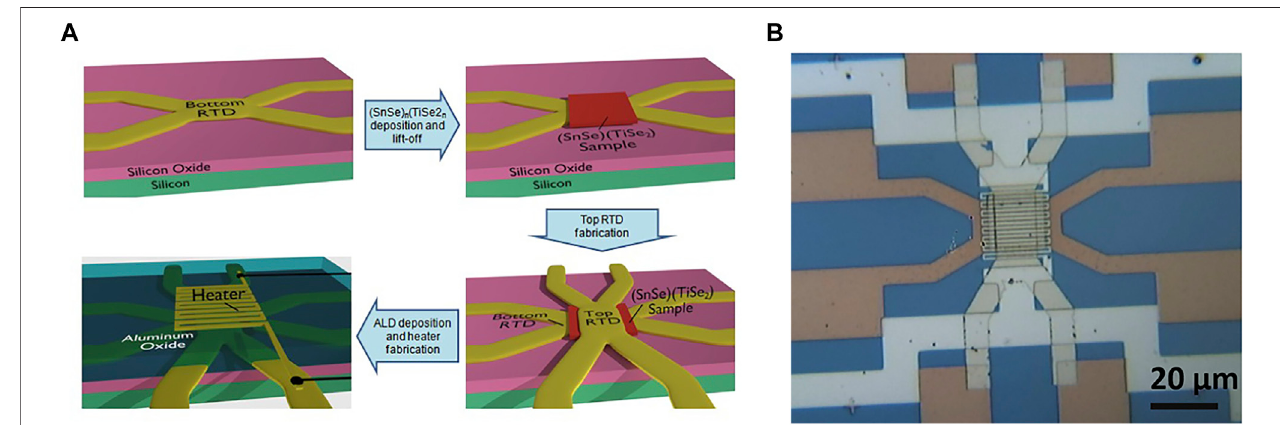
FIGURE 7 | (A) Schematic diagrams illustrating the device fabrication process, and (B) Optical microscope image of an established device. Reprinted with permission from Ref. [118], Copyright 2017, American Chemical Society.